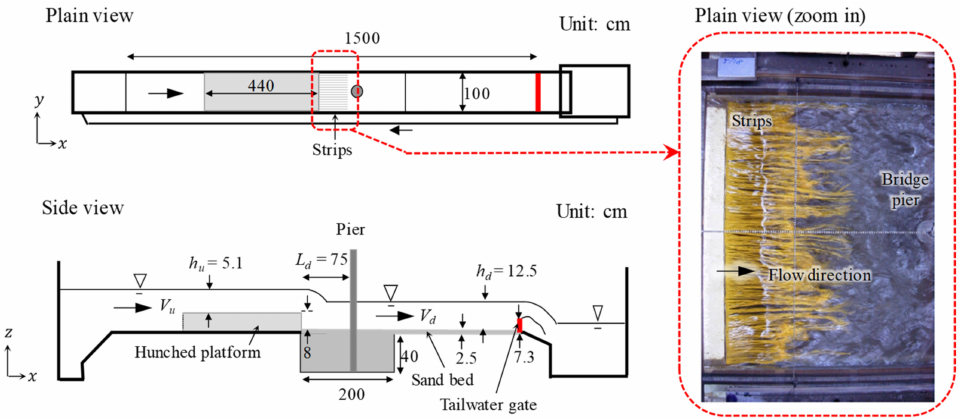
Figure 6. Setup of the experiment